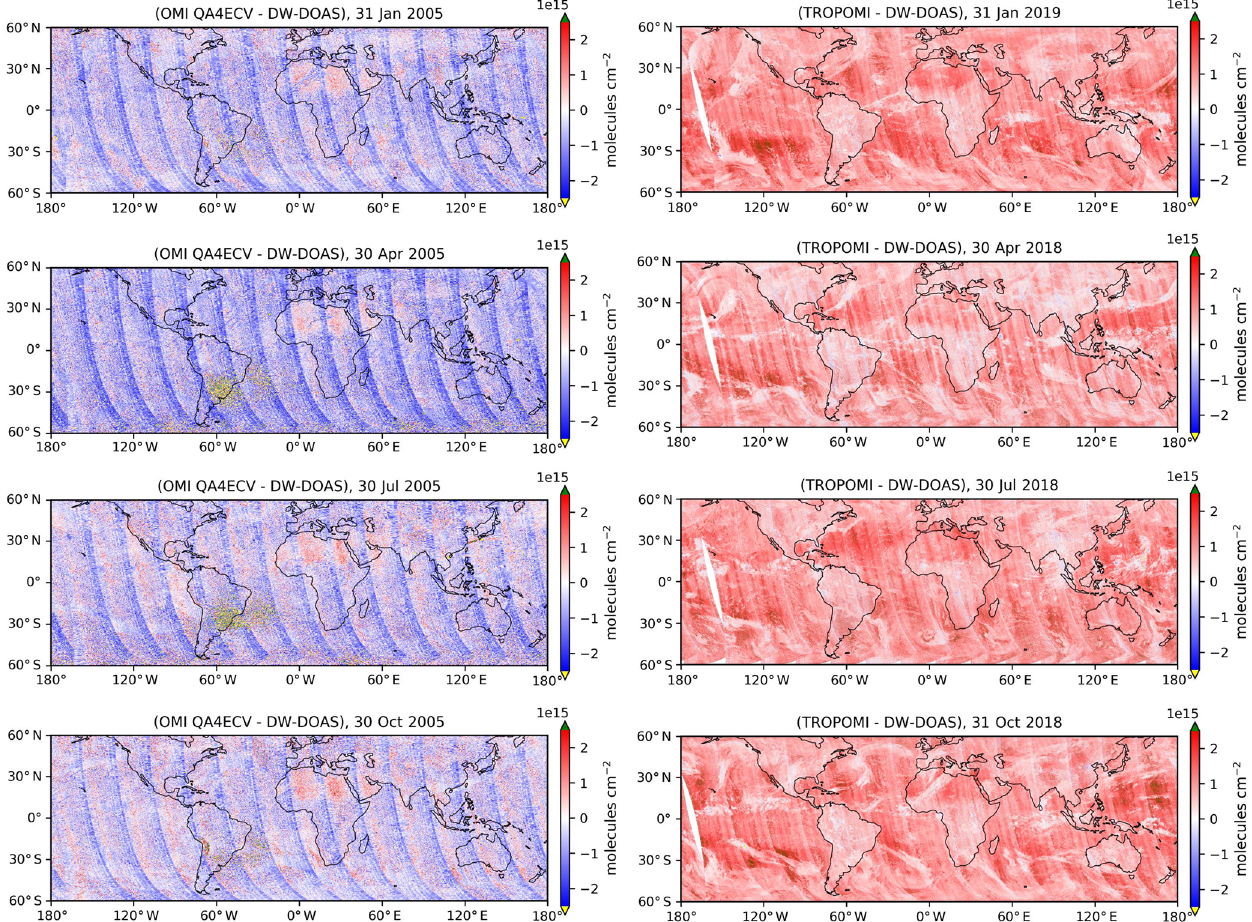
Figure A1. Absolute differences between DW-DOAS and (left) OMI QA4ECV and (right) TROPOMI, for the data shown in Figs. 5 and 9. The differences are expressed in terms of the SCD scaled with the geometric AMF. The latitudes are limited to [60 ◦ S, 80 ◦